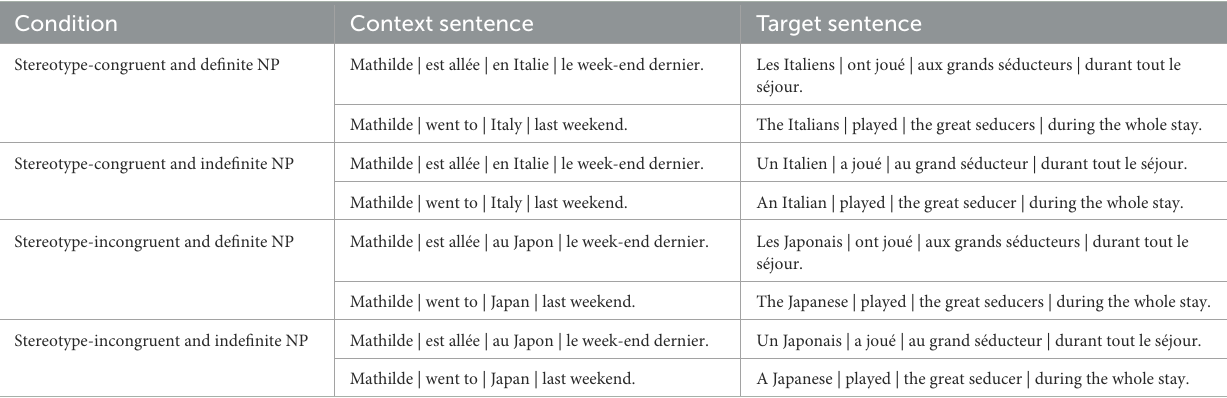
TABLE 5 Example of a stimulus of Experiment 2 in the four experimental conditions.